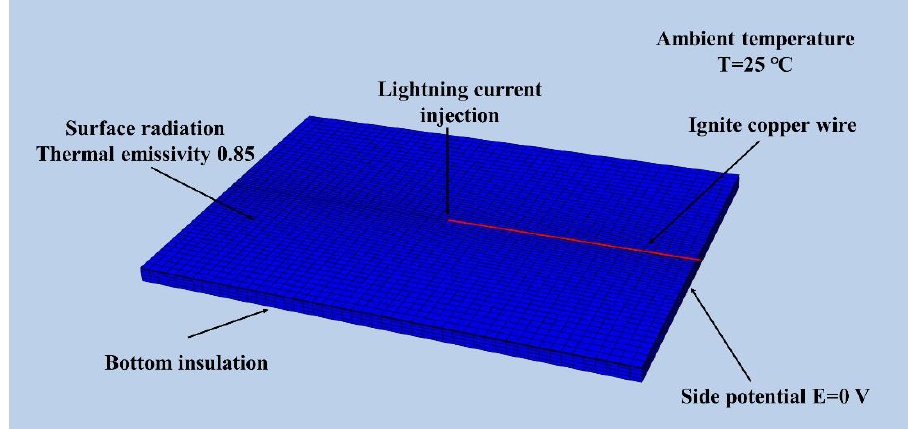
Figure 6. Lightning current loading diagram and boundary conditions along the surface of GFRC laminates.